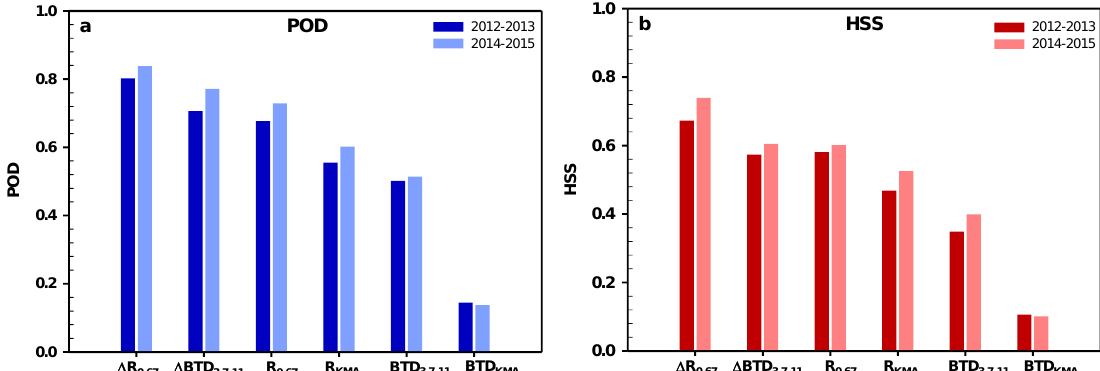
Figure 7. Statistical verification with respect to six threshold components ( ∆ R 0.67 , ∆ BTD 3.7-11 , R 0.67 , R KMA , BTD 3.7-11 , and BTD KMA ) for Period 1 (control data period) and Period 2 (experimental data period) of ( a ) POD and ( b ) HSS. The six threshold values were verified by using ground observations from 754 fog and 433 clear-sky occurrences in South Korea.